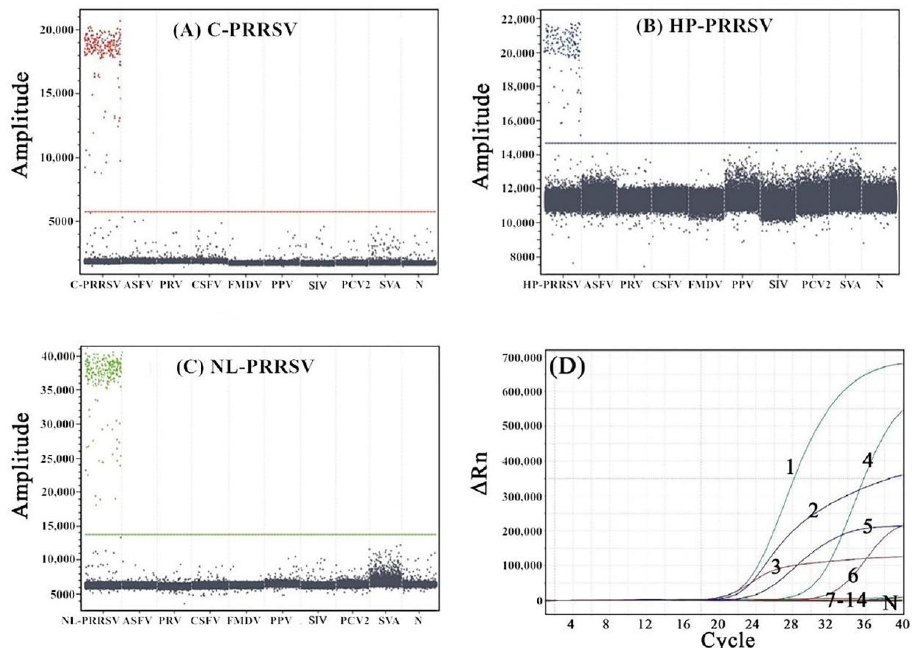
Figure 4. The specificity analysis of the multiplex cdPCR ( A – C ) and qRT-PCR ( D ). ( A – C ) show the results of the multiplex-cdPCR-specific tests of C-PRRSV, HP-PRRSV, and NL-PRRSV, respectively. ( A ): C-PRRSV, ( B ): HP-PRRSV, and ( C ): NL-PRRSV. ( D ) shows the results of the multiplex-qRT-PCR-specific tests of C-PRRSV, HP-PRRSV, and NL-PRRSV. 1: p-NL-PRRSV; 2: p-HP-PRRSV; 3: p-C-PRRSV; 4: NL-PRRSV; 5: HP-PRRSV; 6: C-PRRSV; and 7 – 14: ASFV, PRV, CSFV, FMDV, PPV, SIV, PCV2, and SVA, respectively. N: negative control.